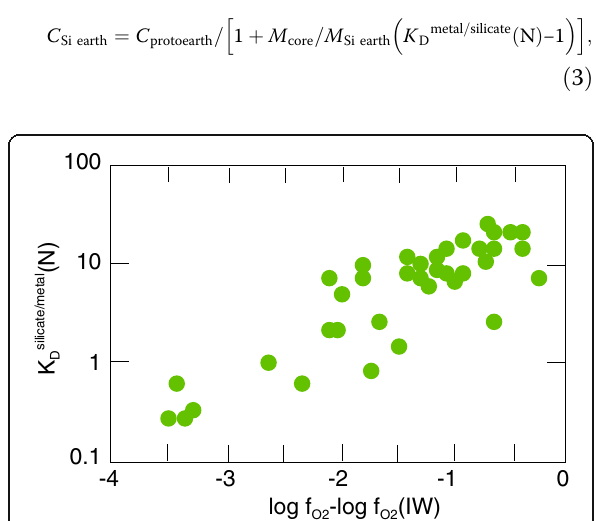
Fig. 11 Fe-rich metal/silicate nitrogen partition coefficient, K D (N), as a function of oxygen fugacity expressed relative to the oxygen fugacity of the iron-wüstite (IW) buffer expressed as base10 log (data from Dalou et al. 2017)